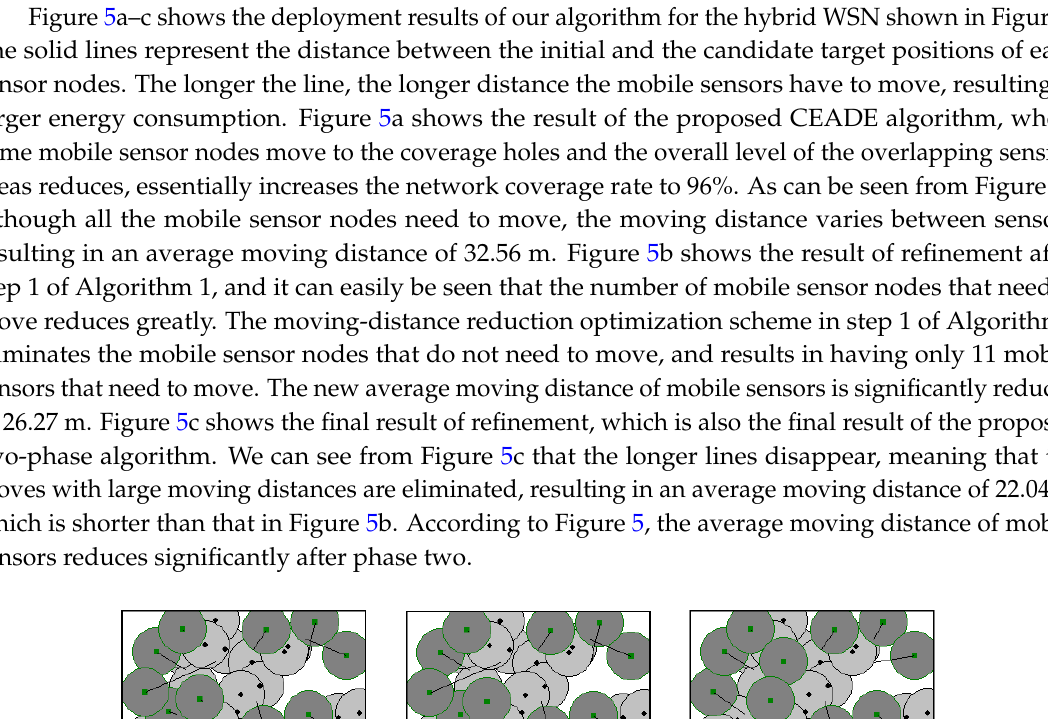
( c ) final refinement result.